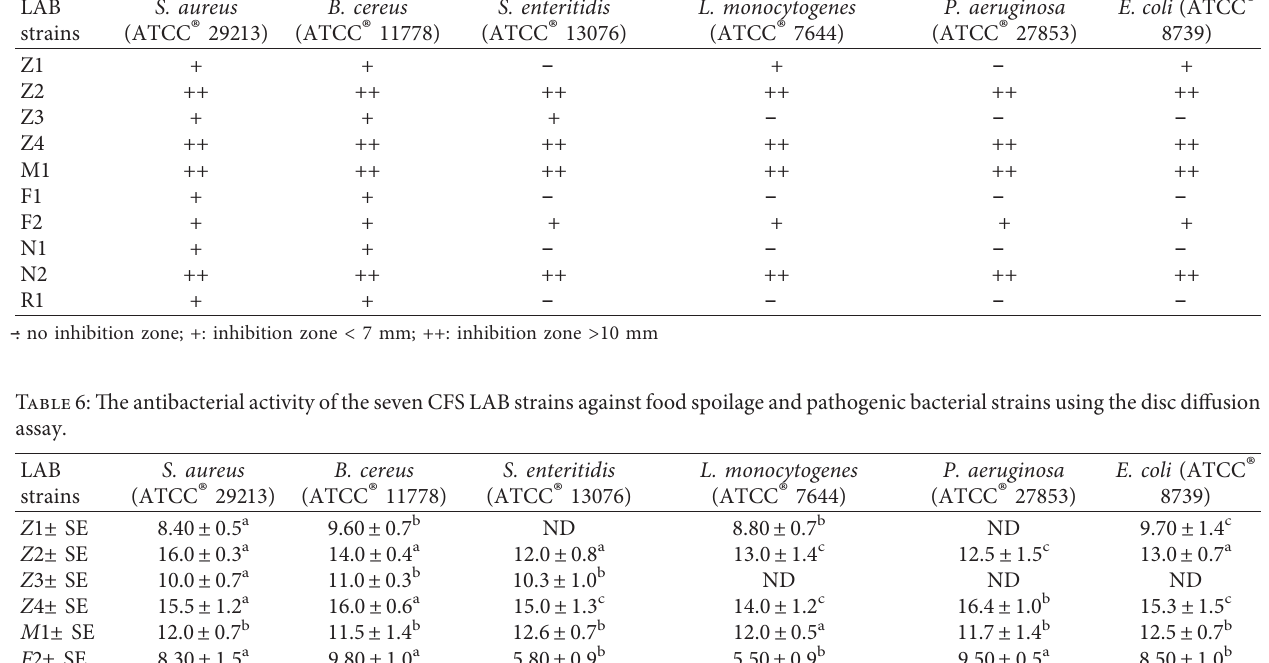
Table 5: Primary screening of LAB strains for antibacterial activity evaluation against food spoilage and pathogenic bacterial strains. LAB strains